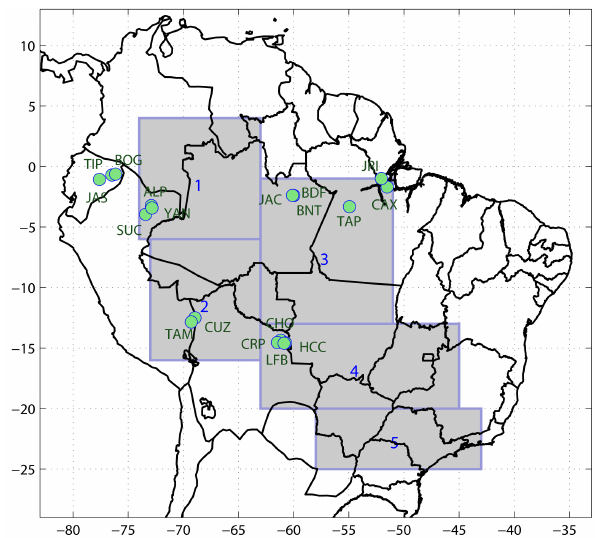
Figure B2. Locations of zones and sites of analysis. Zones are numbered 1 through 5, and reflect geographic areas where model and observation spatial means are compared for validation (see Ap- pendix D and E). Forest census plot sites from Baker et al. (2004a, b) are referenced with green markers and their station code.